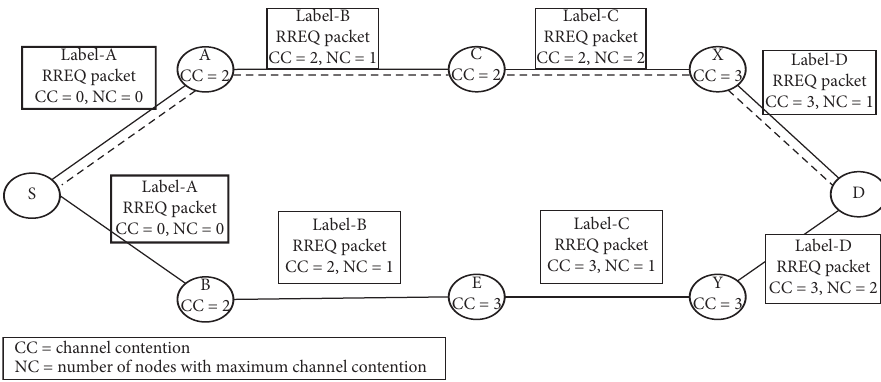
Figure 3: A wireless ad hoc network scenario.